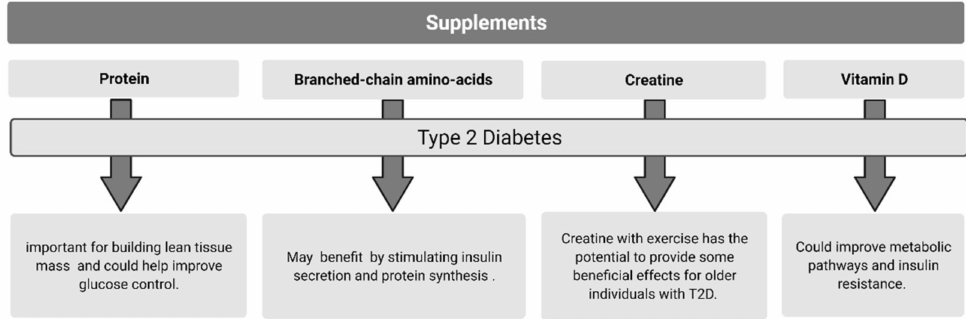
Figure 2. Purported supplements to improve type 2